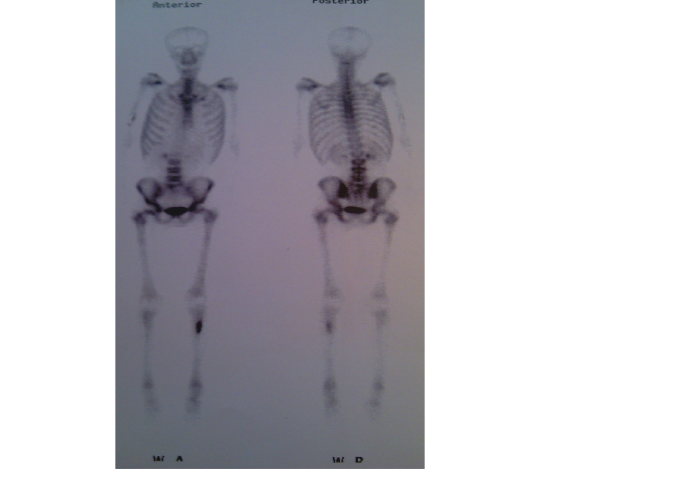
Figure 2: Whole-body bone scan with Tc-99m MDP, the lesion showed activity in all 3 phases and was the only site of skeletal involvement.